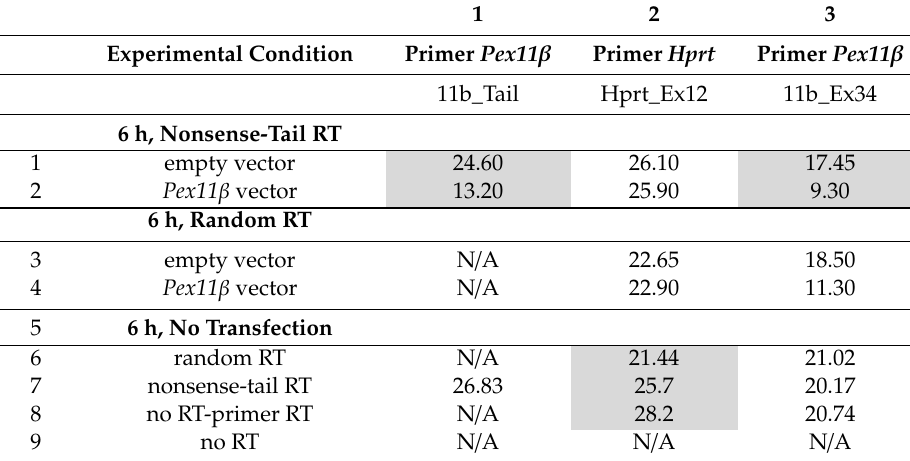
Table 4. We selectively reverse transcribed plasmid-derived mRNA using a nonsense-tail RT primer (nonsense-tail RT), which was quantified by PCR using a PCR primer pair (11b_Tail), matching to the 3’end of Pex11 β transcript (forward primer) and to the nonsense-tail region (reverse primer). A comparison of the ct values of the PCR products of 11b_Tail and the Pex11 β exon 3–4 spanning primer (11b_Ex34) revealed that only 7% (line 2, column 1 vs. 3, calculation based on Equation (2)) of the residual plasmid DNA was transcribed into (plasmid-derived) mRNA. The mouse endogenous genome-derived mRNA was reverse transcribed independently of an RT primer and thus in the nonsense-tail RT as well. However, only 0.7% of the total genomic DNA-derived mRNA was detected (calculation based on Equation (2)) using the 11b_Tail PCR primer, as calculated by comparing the ct values of the products of the 11b_Tail (column 1, line 1) and those of the 11b_Ex34 PCR primer (column 1, line 3).